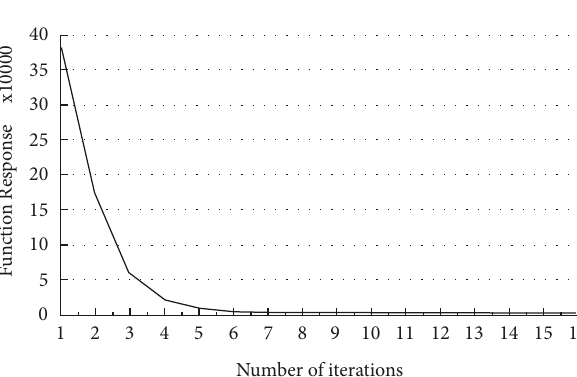
Figure 8: Optimization iteration curve based on the average frequency method.